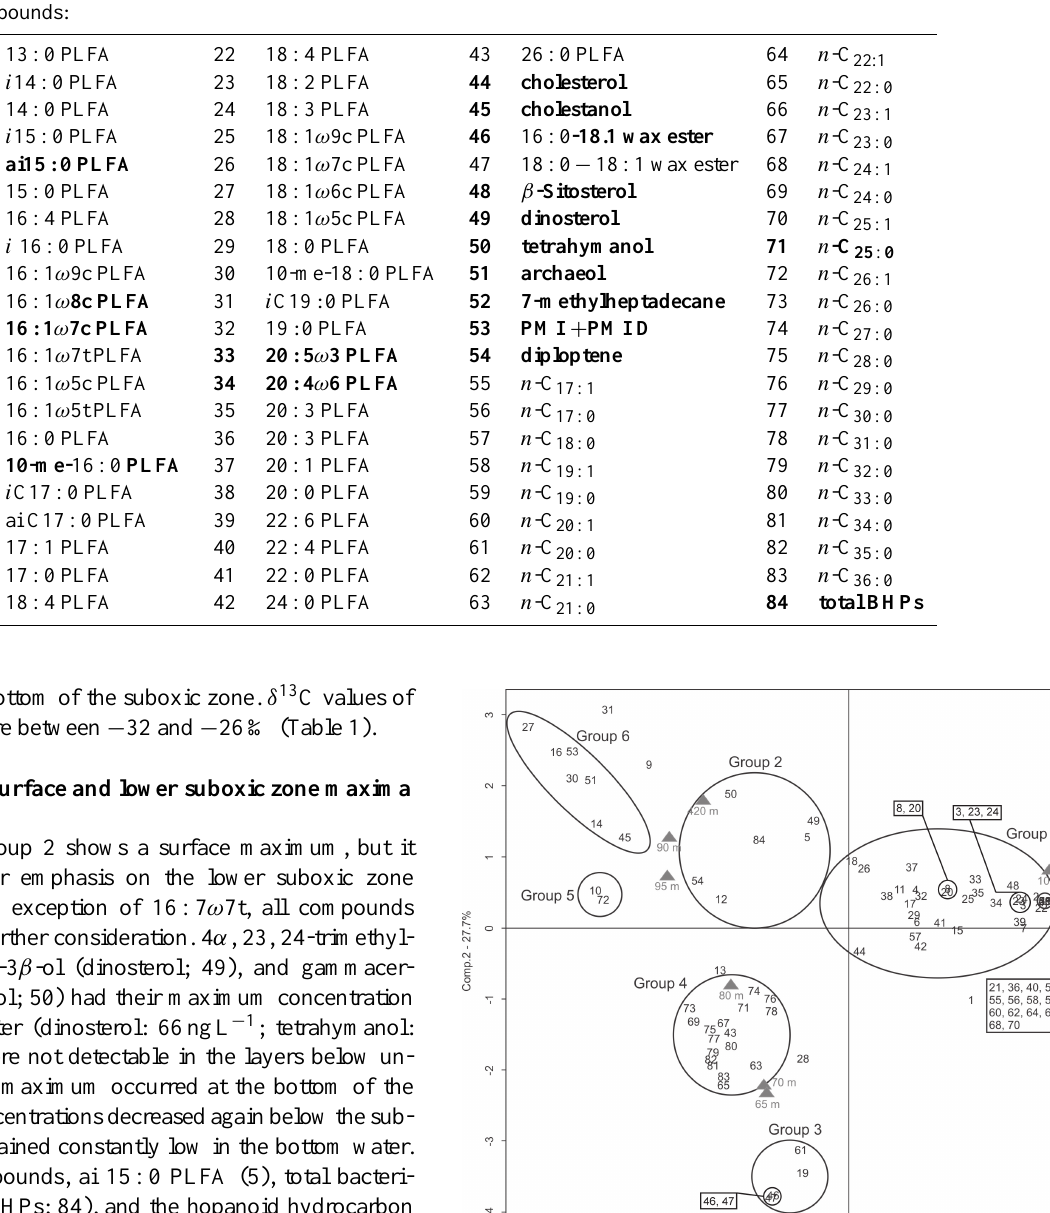
Table 2. Compounds sorted by number as shown in Fig. 3. Compounds chosen for further discussion are marked bold. Compounds: